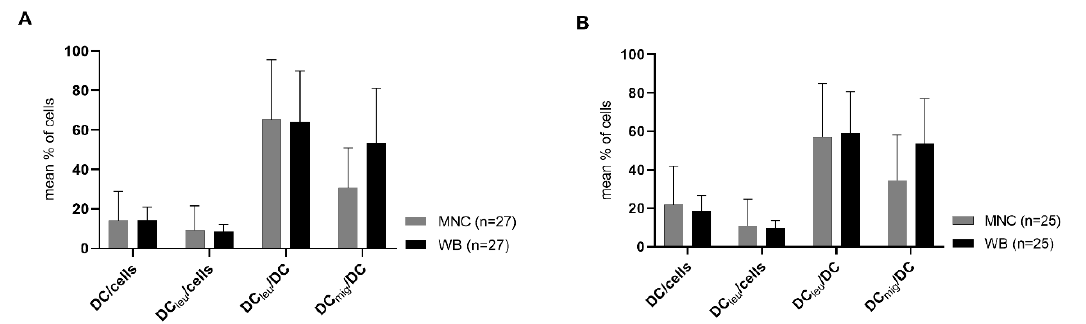
Figure A1. DC/DC leu -generation from leukaemic WB and MNC with standard DC/DC leu -generating protocols (Ca, Mcm, Pici). Given are the mean ± SD of DC/cells, DC leu /cells, DC leu /DC and DC mig /DC generated with the standard protocol Ca ( A ) and Pici ( B ) from MNC compared to WB. Statistically significant differences ( p values < 0.05) (two-tailed t -test) are given.